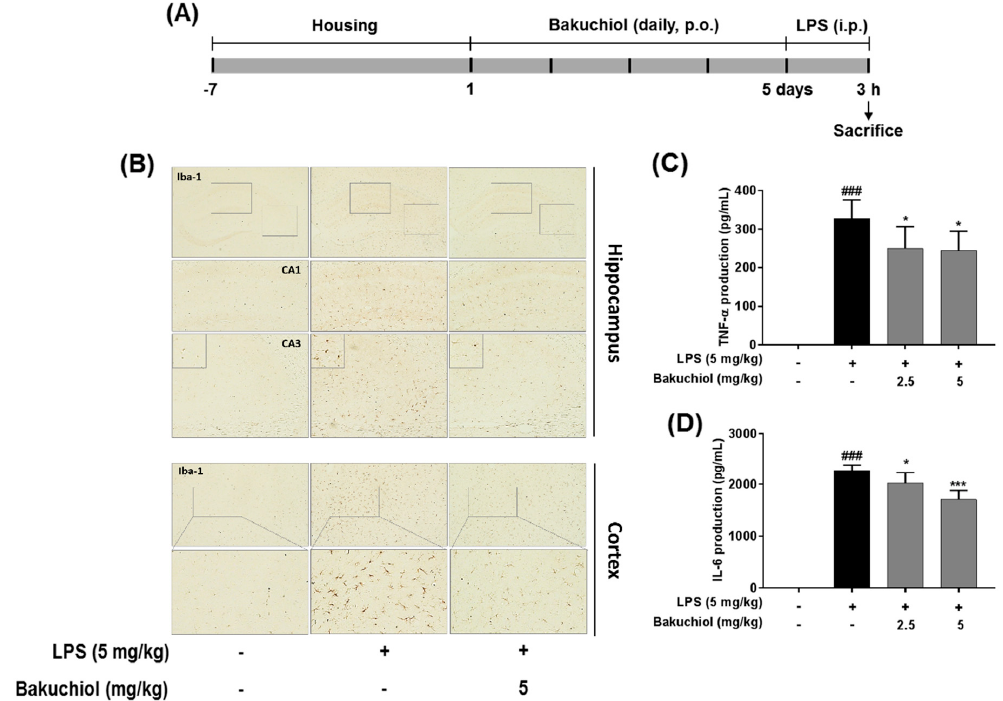
Figure 5. E ff ects of bakuchiol on neuroinflammation in LPS-induced mice. Mice were assigned to four groups ( n = 7 / group) and administered vehicle (saline) or bakuchiol at doses of 2.5 or 5 mg / kg orally for 5 days after adaptation for 1 week. On day 5, LPS (5 mg / kg) were administered 3 h before the sacrificed ( A ). Immunoreactive cells of anti-Iba1 antibody was investigated in the brain hippocampus and cortex by immunohistochemistry analysis ( B ). Production of TNF- α ( C ) and IL-6 ( D ) in the serum were measured using ELISA. The results are expressed as the mean ± SEM of three independent experiments. ### P < 0.001 vs untreated control cells and * P < 0.05 or *** P < 0.001 vs LPS-treated cells.